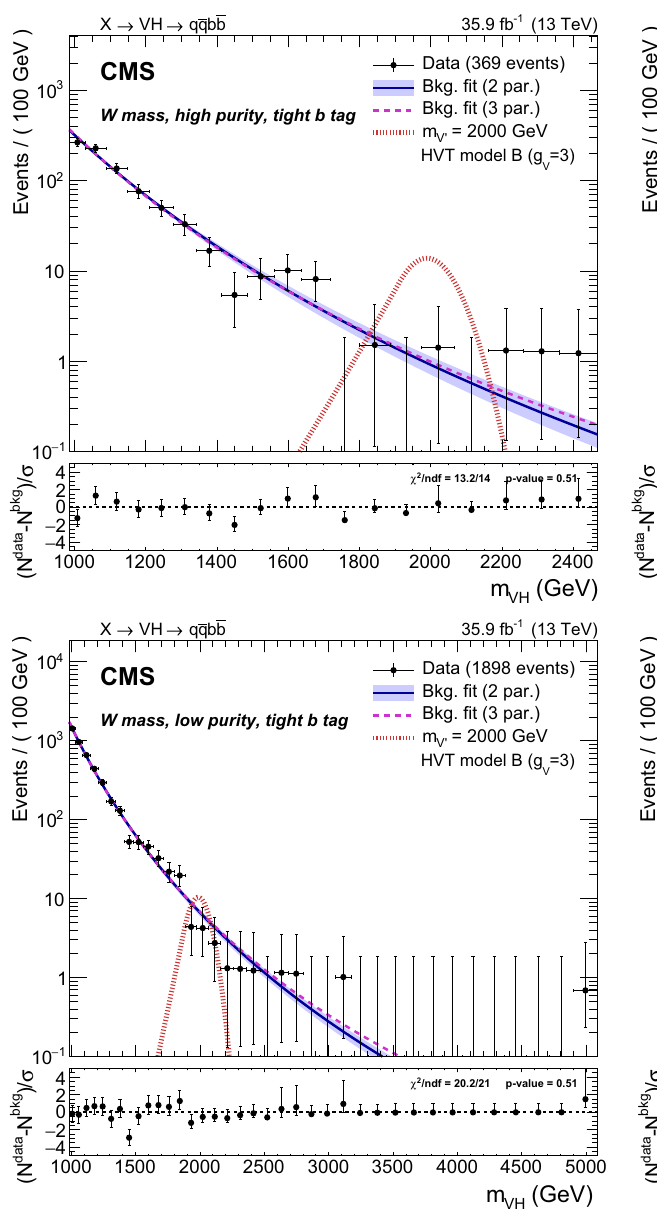
Fig. 3 Dijet invariant distribution m VH of the two leading jets in the W mass region: high purity (upper) and low purity (lower) categories, with tight (left) and loose (right) b tagging selections. The preferred background-only fit is shown as a solid blue line with an associated shaded band indicating the uncertainty. An alternative fit is shown as a purple dashed line. The ratio panels show the pulls in each bin,